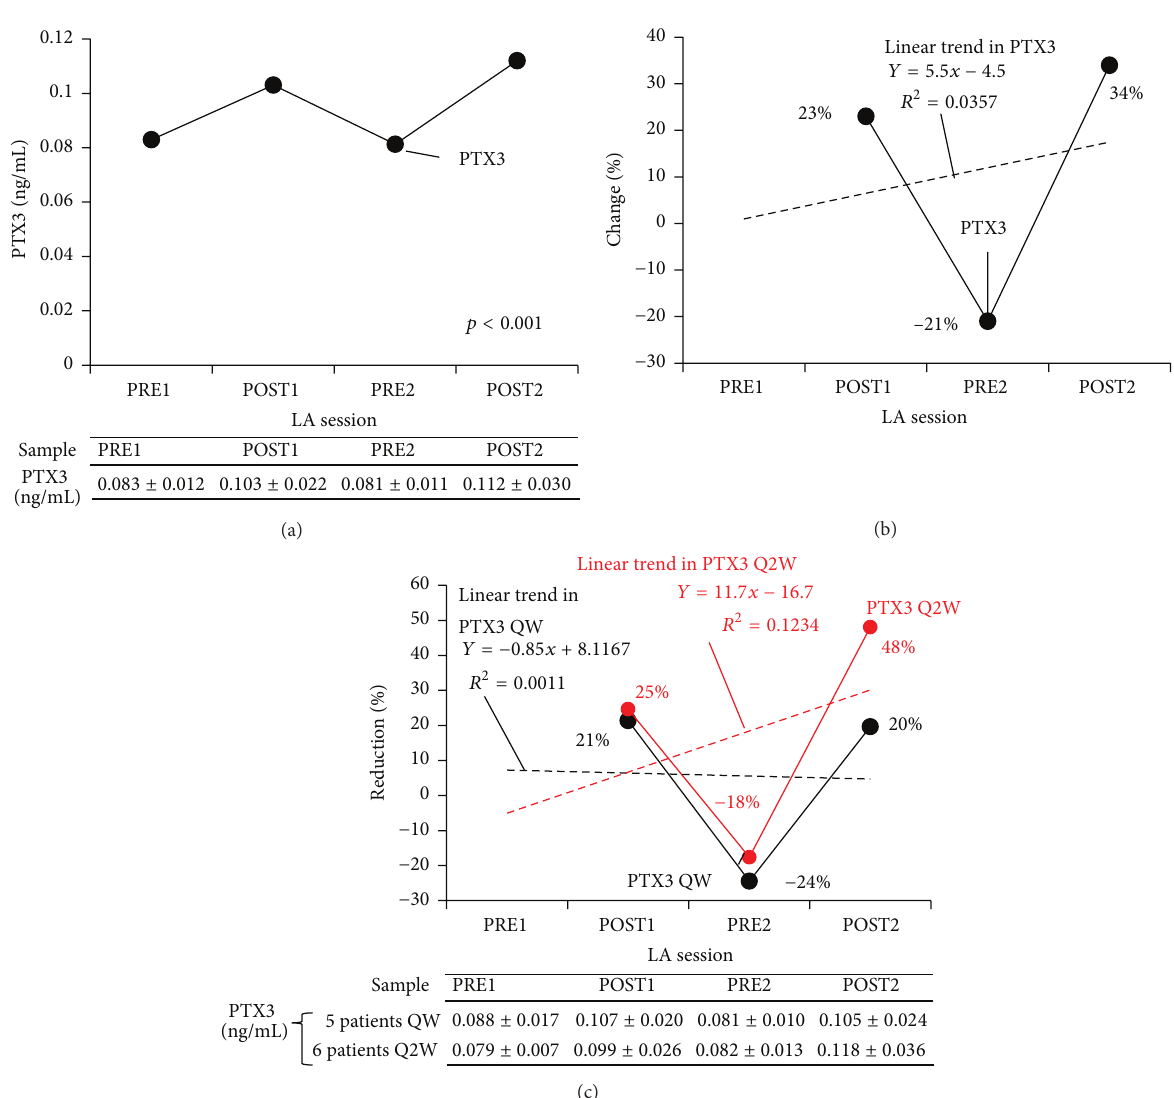
Figure 2: Effect of LA treatment on PTX3 peptide expression (ELISA) (a) and change in expression in all patients (b) and by LA schedule (c) in patients with HyperLp(a) ( 𝑛 = 11 ). LA, lipoprotein apheresis; PTX3, pentraxin; ELISA, enzyme-linked immunosorbent assay; HyperLp(a), hyperLp(a)lipoproteinemia; POST1, blood sample collected after first LA session; PRE2, blood sample collected before second LA session; POST2, blood sample collected after second LA